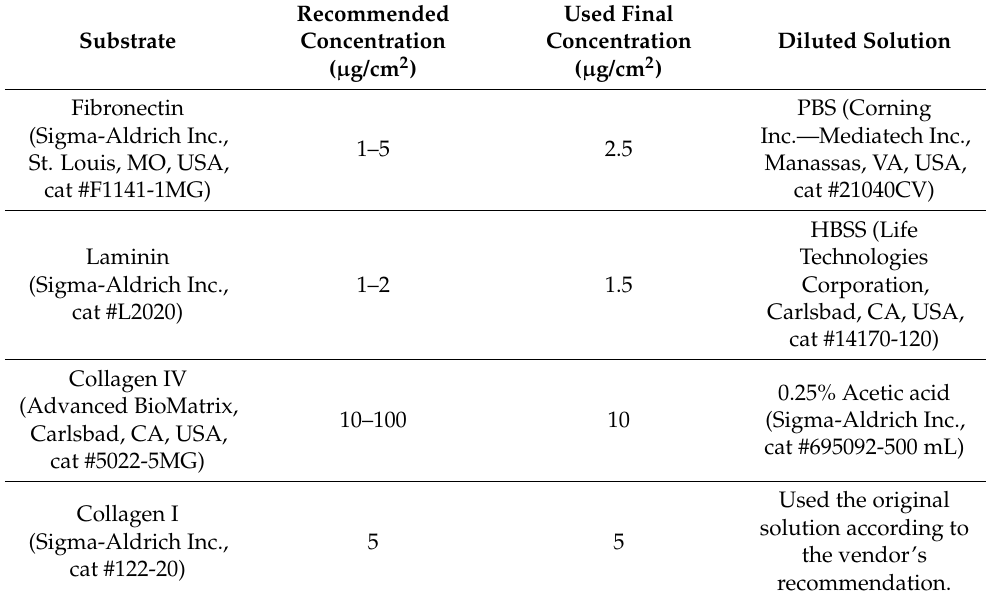
Table 1. Calculations for different ECM protein